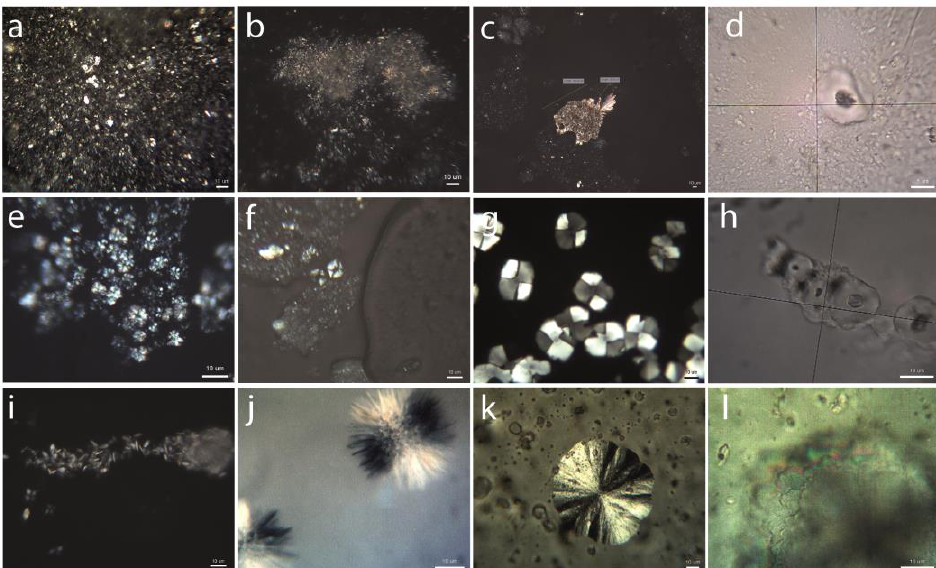
Figure 2. Crystalline specimens and other particles observed on the epigenetic surface film formed in the intonachino by POM. ( a ). External face of the gel-like stratum featuring a cryptocrystalline texture; ( b ). Internal face of the gel-like stratum with a microgranular texture; ( c ). Prismatic hexag- onal crystal (portlandite) in process of dissolution/transformation; ( d ) Particle showing heterogene- ous growth nucleus; ( e ) Botryoidal aggregates; ( f ) Amoeboid aggregates; ( g ) Sectorial-structure crystal aggregates; ( h ) Sectorial-structure chain-like aggregates; ( i ) Lenticular and rhombohedral crystal aggregates; ( j ) Acicular-radial aggregates; ( k ) Lamellar-radial spherulite; ( l ) Axial stacking of lamellar-radial spherulite.